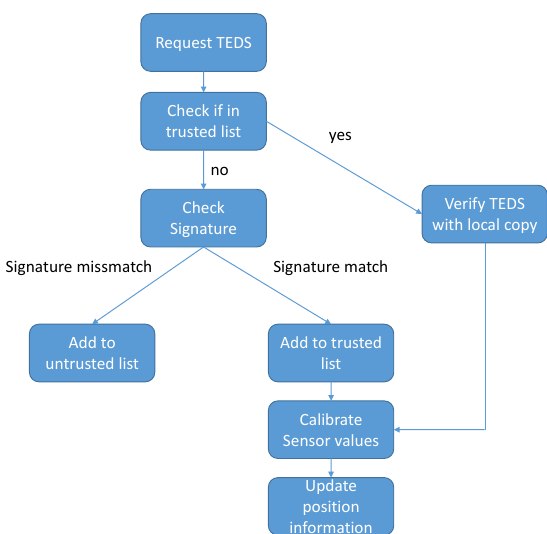
Figure 5. Flow graph of landmark verification